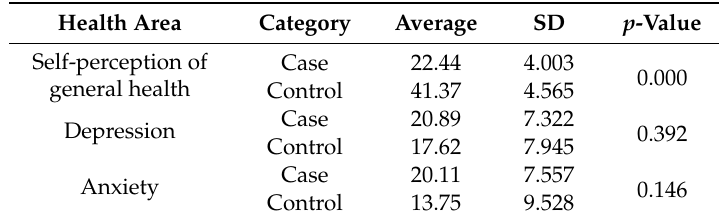
Table 1. Comparison of the emotional state of mothers carrying microcephalic (cases, n = 9) and normocephalic (control, n = 8) children.